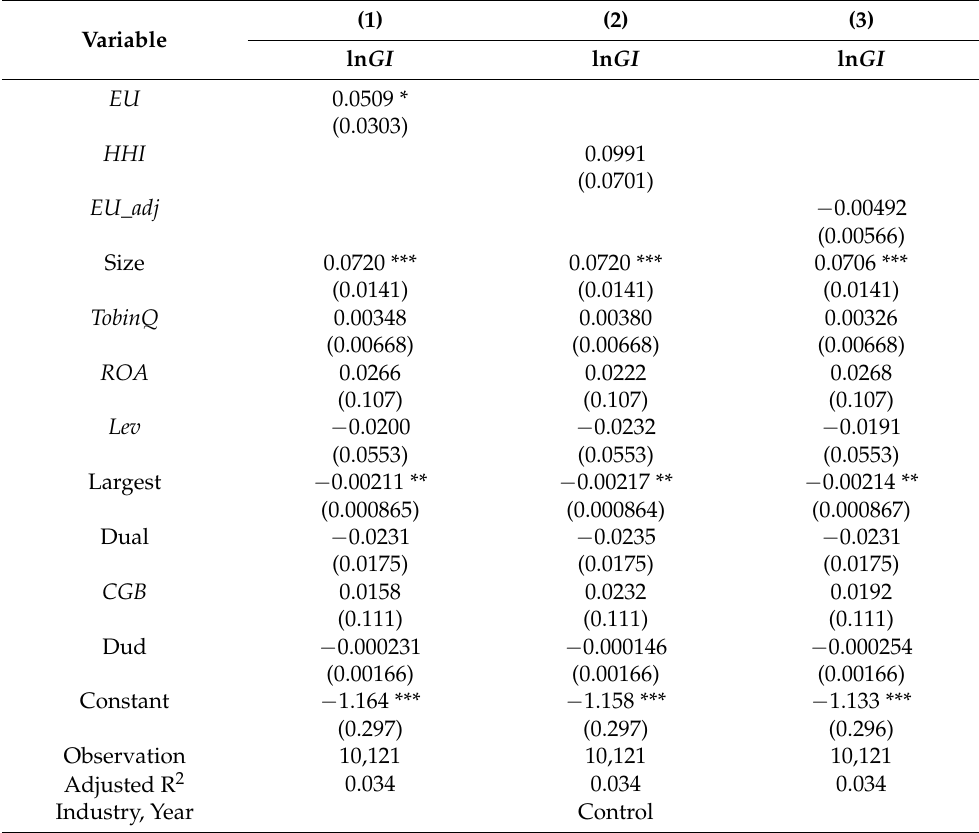
Table 7. Regression Analysis of Environmental Uncertainty and Green Technological Innovation of Non-SOEs.